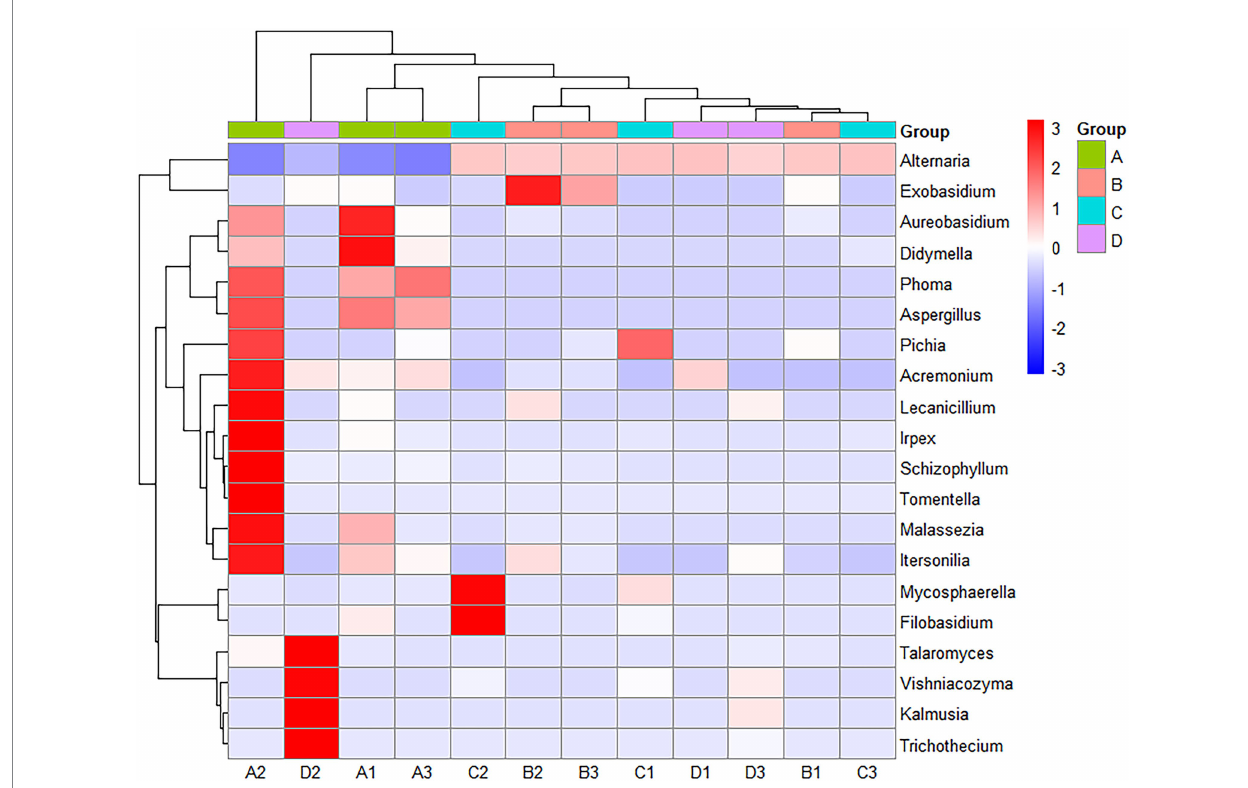
FIGURE 4 A cluster heatmap of the flora at the genus level. The red patch in the figure indicates that the genus is more abundant in this sample than in the other samples, and the blue patch indicates that the genus is less abundant in this sample than in the other